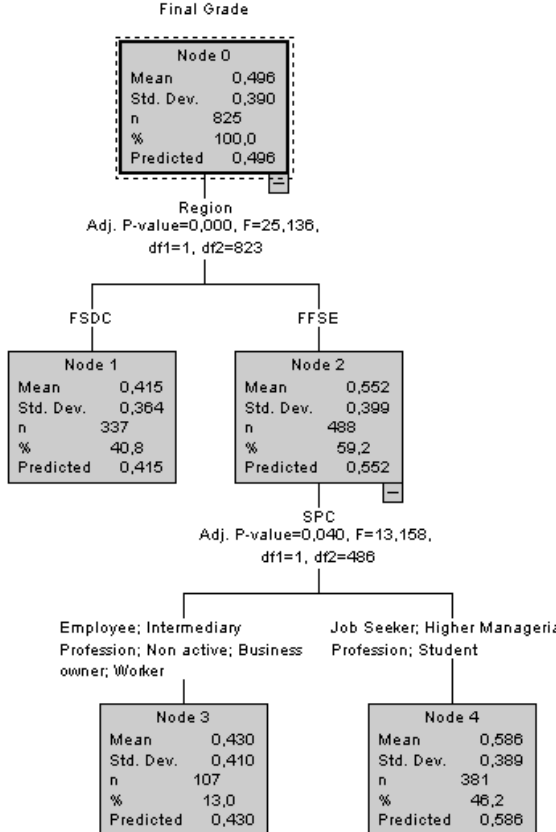
Figure 3. CHAID analysis with final grade as dependent variable (without Academic Cohorts).